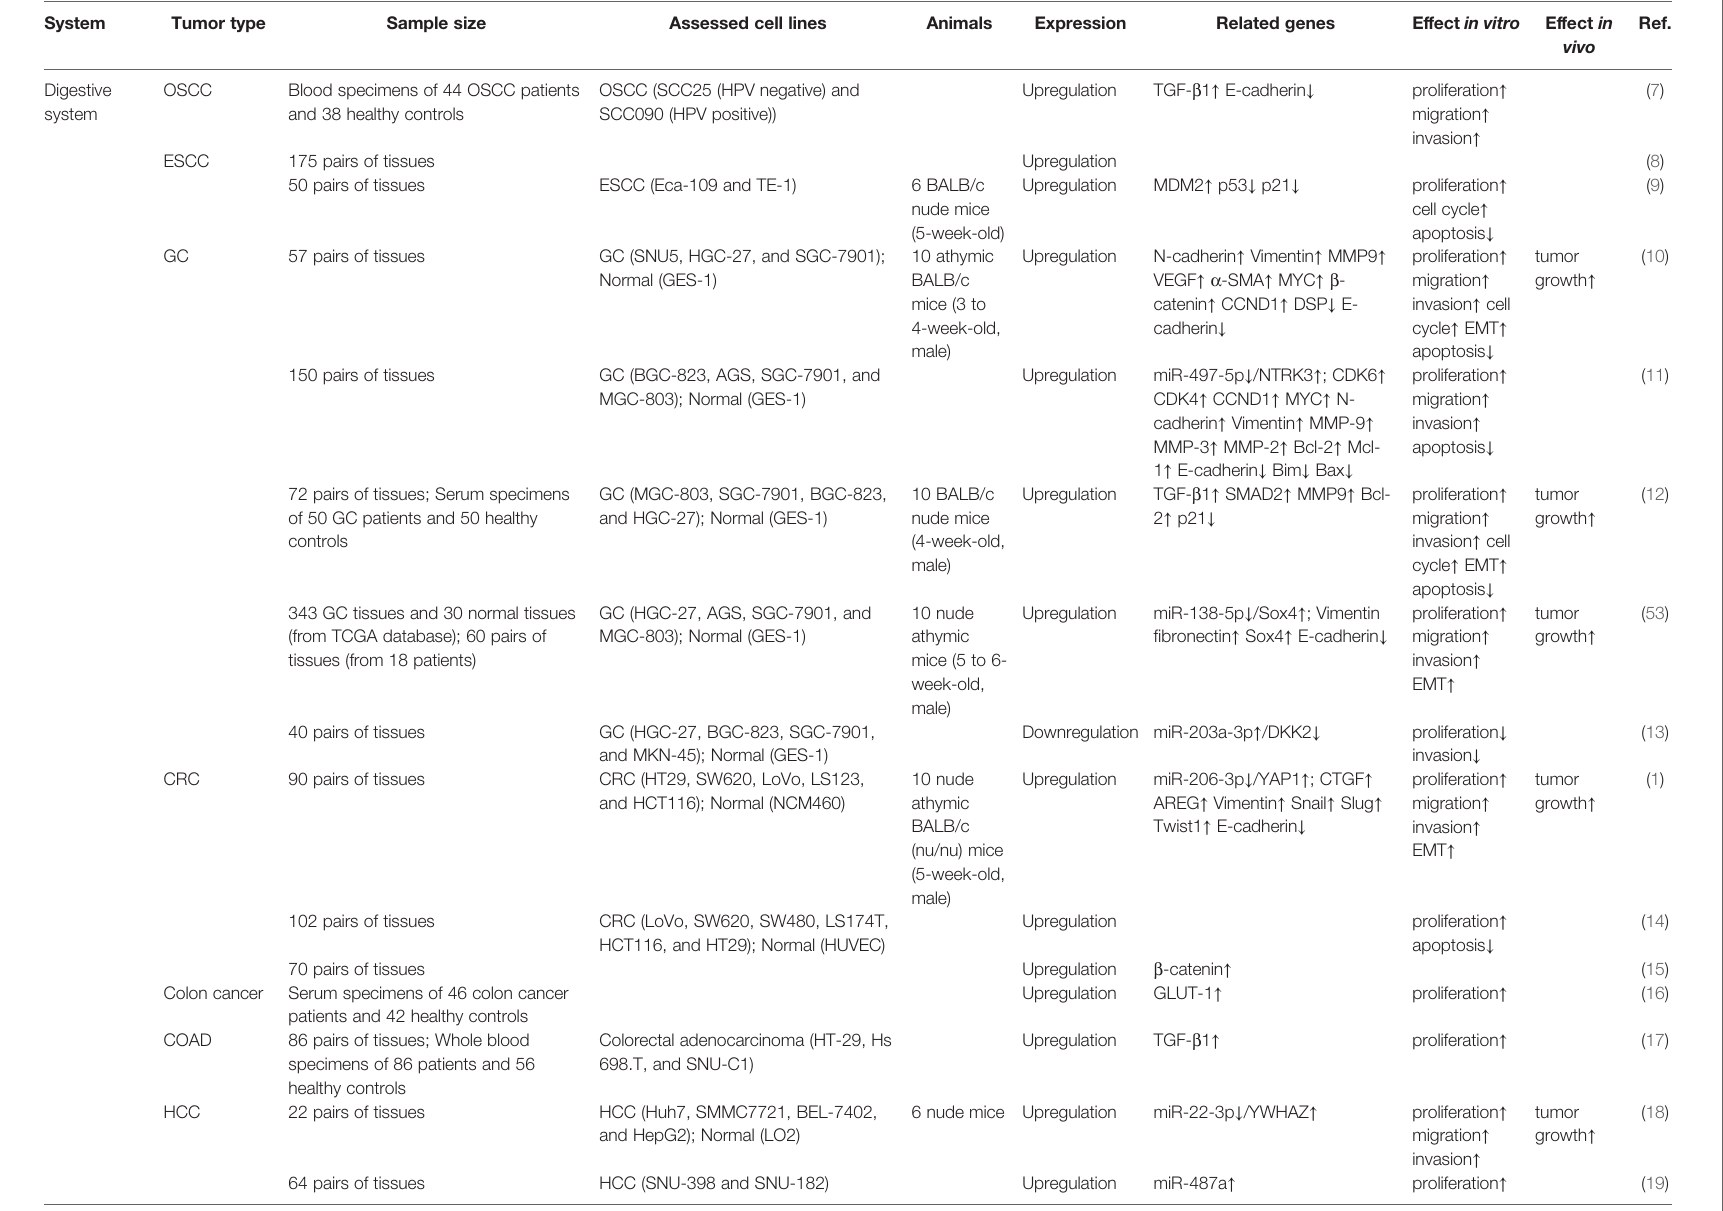
TABLE 1 | Expression level and biological functions of MIR4435-2HG in human